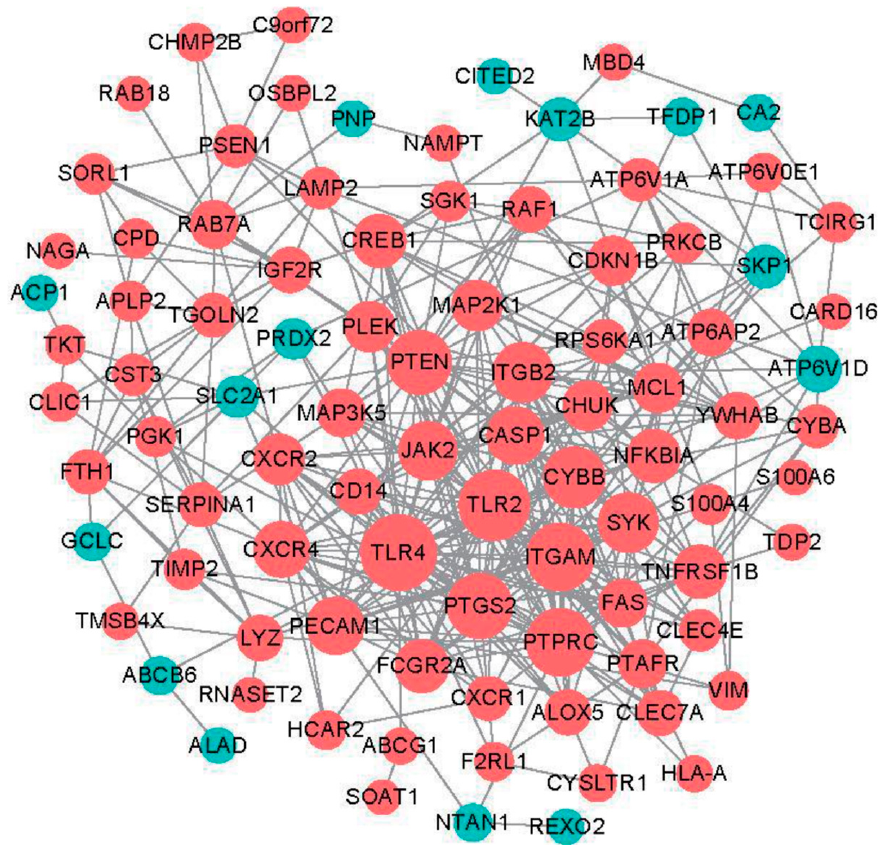
Figure 5. A protein–protein interaction (PPI) network consisting of 106 DE-CMR-SONFHGs was constructed. Red circles represent up-regulated genes, and green circles represent down-regulated genes. LASSO logistic regression and the SVM algorithm were utilized to identify key DE- CMR-SONFHGs. When lambda.min was 0.1073883, the error rate was the lowest, and two candidate genes, namely PNP and SLC2A1, were identified via LASSO (Figure 6A,B). Additionally, eight candidate genes, including RNASET2, PNP, SLC2A1, REXO2, CYBA, SOAT1, TFDP1, and LYZ, were selected using SVM (Figure 6C and Table 2). Finally, two genes (PNP and SLC2A1) were identified in the results of both LASSO and SVM (Figure 6D). The ROC curves revealed that the area under the curve (AUC) values of PNP and SLC2A1 in the GSE123568 dataset were both above 0.9, indicating that each key gene had diagnostic value in distinguishing between SONFH samples and control samples (Figure